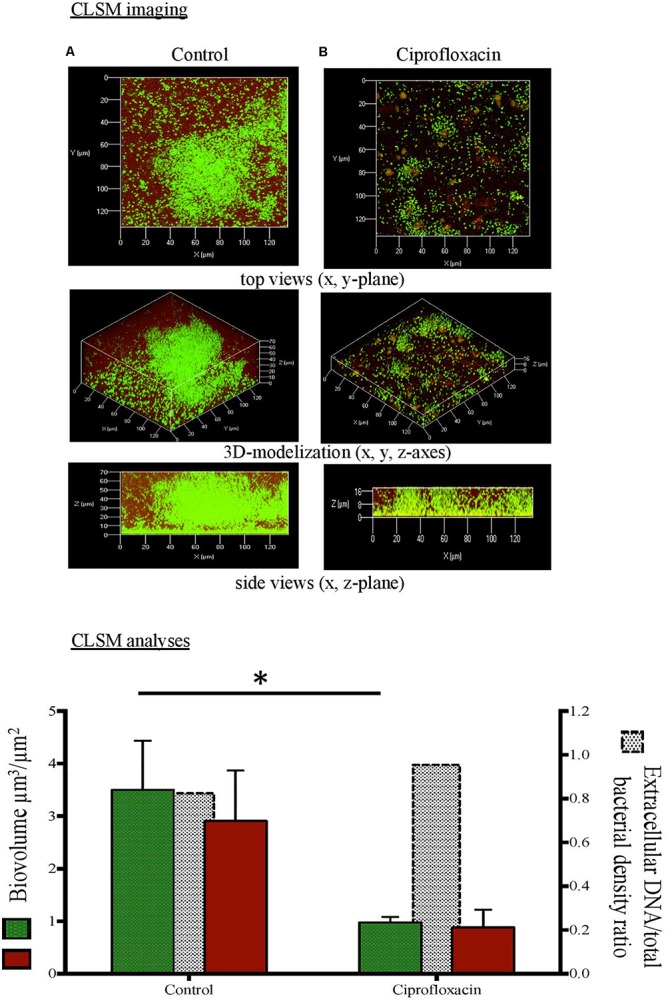
Confocal laser scanning microscopy (CLSM) analysis of Pseudomonas aeruginosa cells and extracellular DNA in biofilm unexposed (A) or exposed to ciprofloxacin during 24 h (B). CLSM imaging: total cells in green and extracellular DNA in red after staining with Syto-9 and DDAO (1,3-dichloro-7-hydroxy-9,9- dimethyl-2(9H)-acridinone). CLSM analyses:  total cells (left x-axis),  extracellular DNA (left x-axis),  extracellular DNA/total bacterial density ratio (right x-axis). ∗p < 0.05.